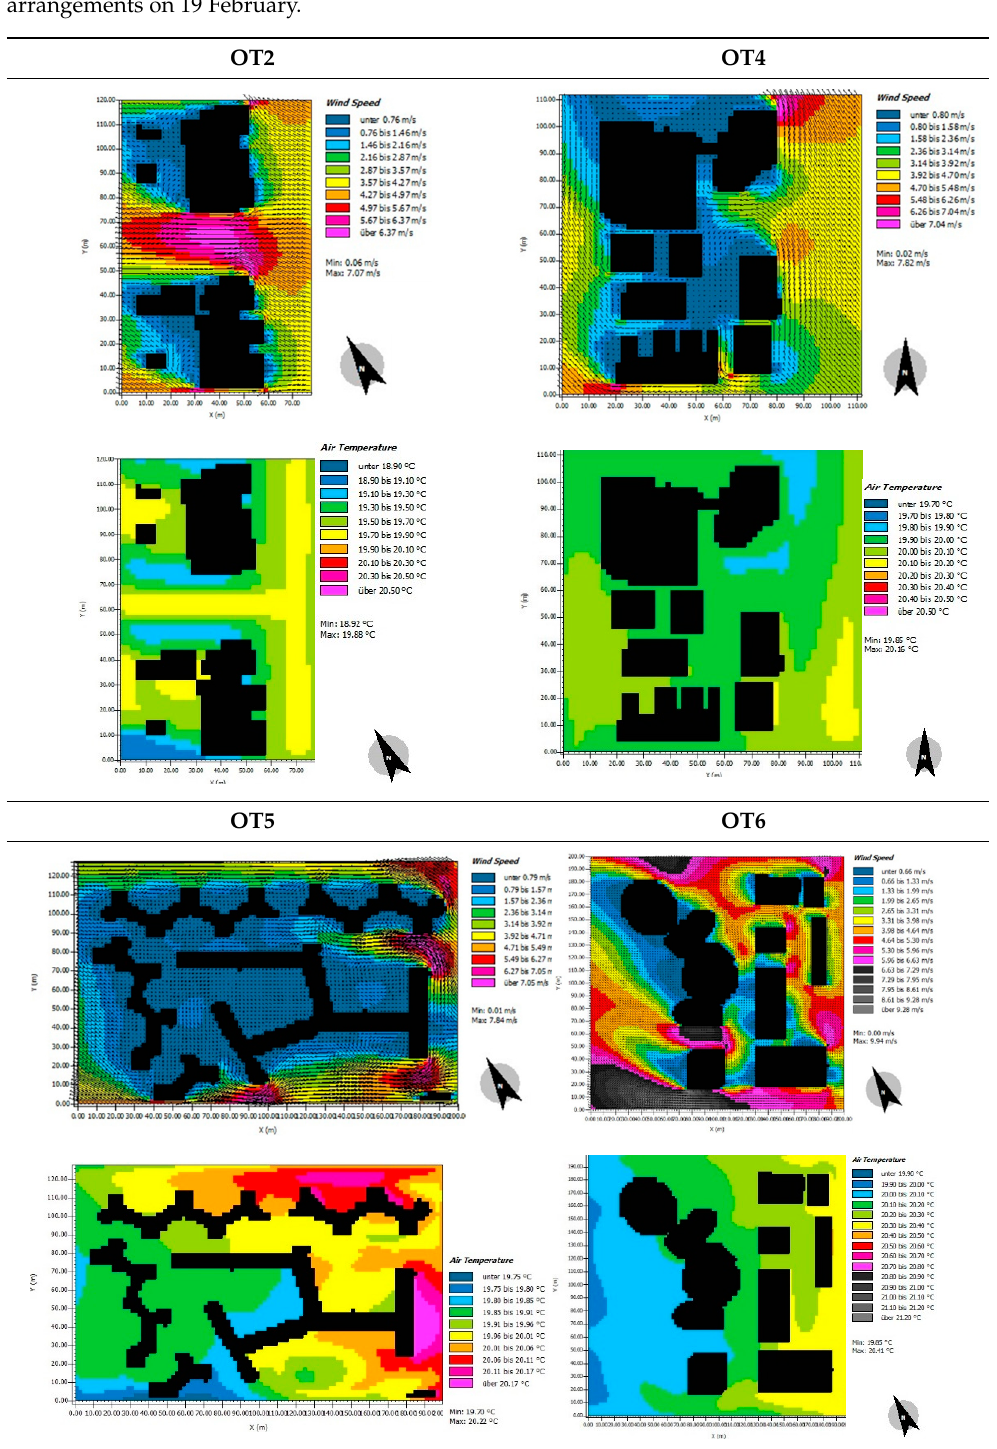
Table 13. A comparison summary of wind speed/direction distribution map across open-type arrangements on 19th February.